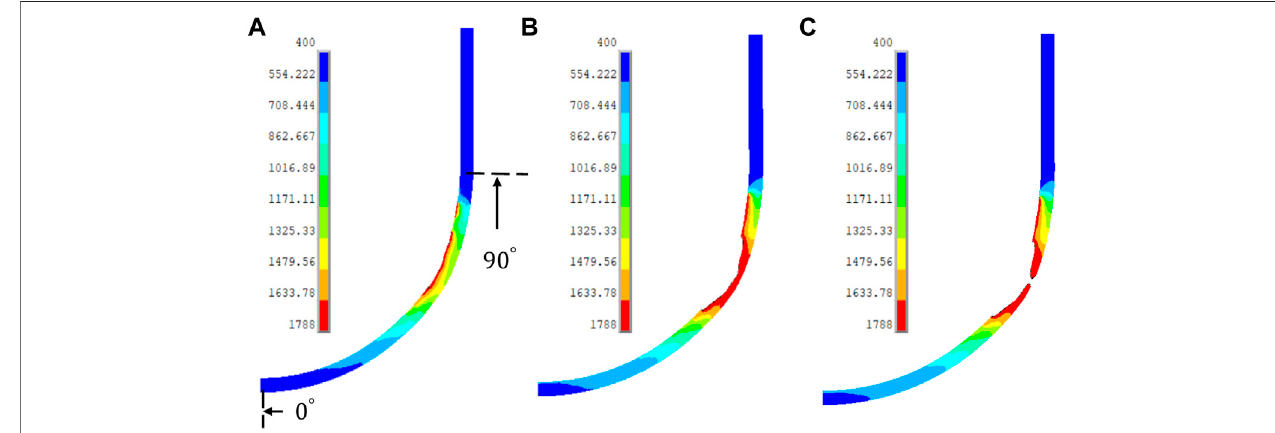
FIGURE 6 | Dynamic ablation for the SBO case: temperature distribution (K) at time (A) t = 6 h, (B) t = 7.16, and (C) t = 7.22 h.